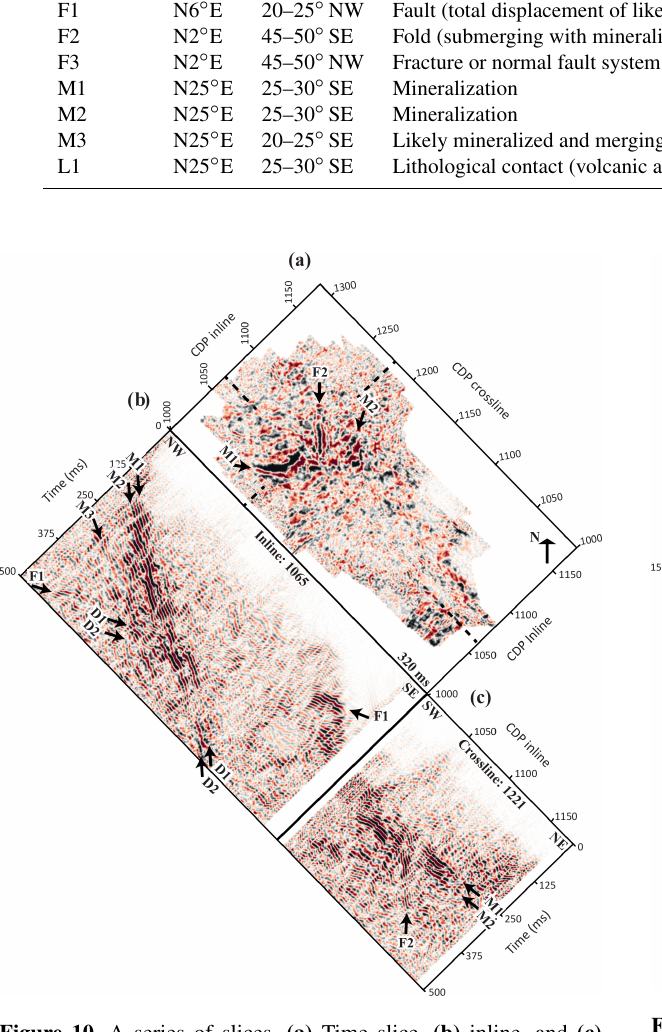
Figure 10. A series of slices. (a) Time slice, (b) inline, and (c) crossline through the unmigrated stacked volume showing two ma- jor sets of southeast-dipping reflections (M1 and M2) terminated by a northwest-dipping one (F1), where two sets of diffractions (D1 and D2) are present at the intersection between the F1, M1, and M2 reflections. The crossline section shows these two sets of reflections have gentle but different dips towards the west. A reflection (F2) ap- pears to cut through these two sets. Another submerging reflection (M3) is observed underlying the M1 and M2 reflections.